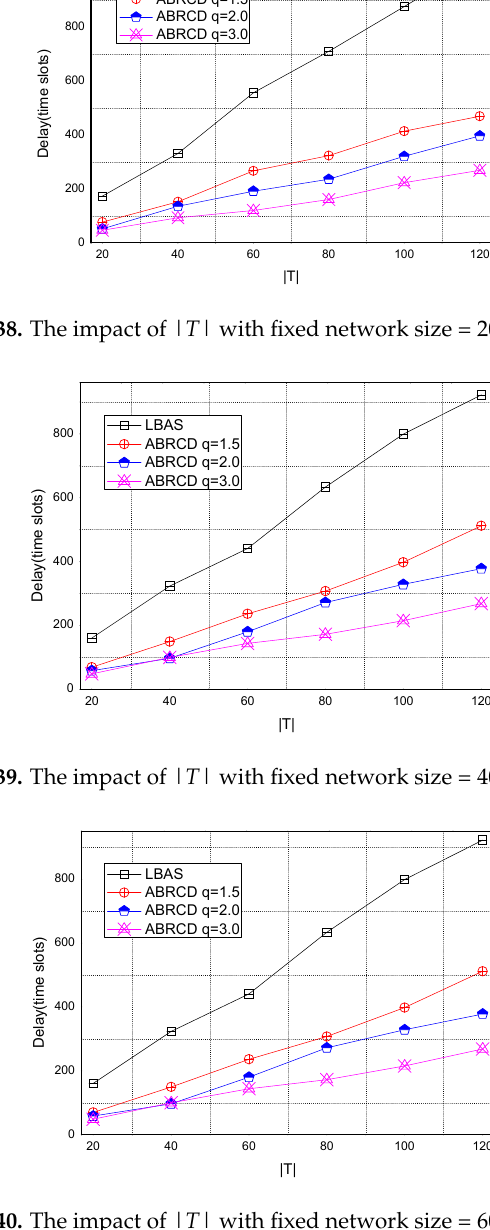
Figure 41. The impact of | T | with fixed network size = 800 on delay.